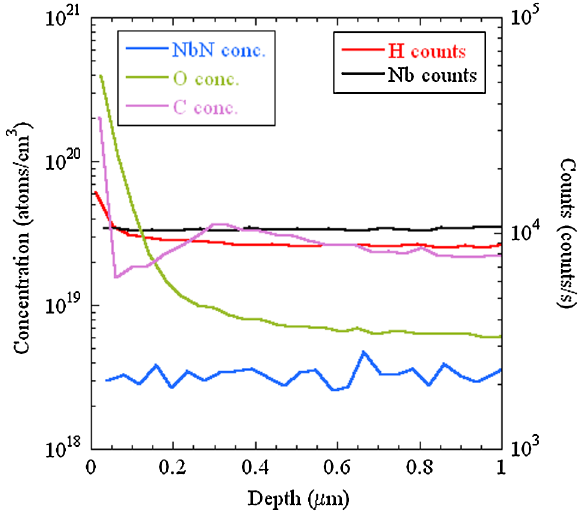
FIG. 24. (Color) SIMS reduced data depth profile for sample L8